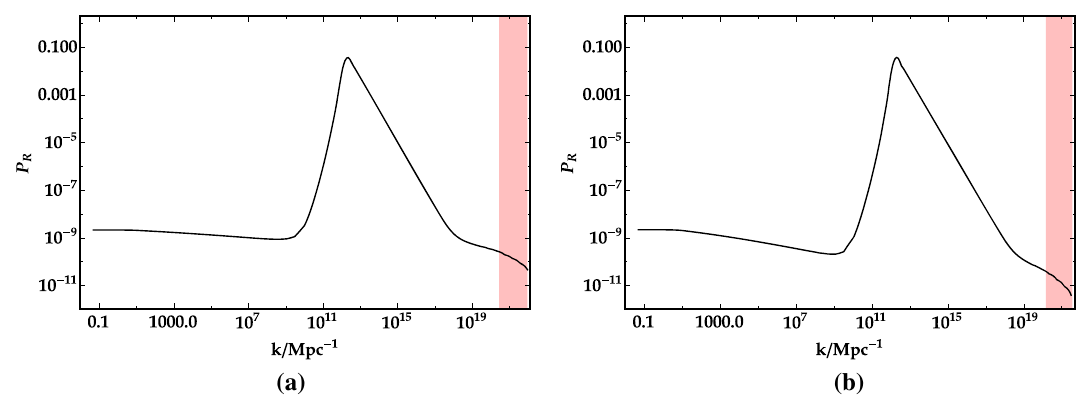
Fig. 5 The scalar power spectrum for the cases a A H and b A N , respectively, in quartic and natural inflation models. The shaded areas denote the scales that re-enter the horizon during the reheating